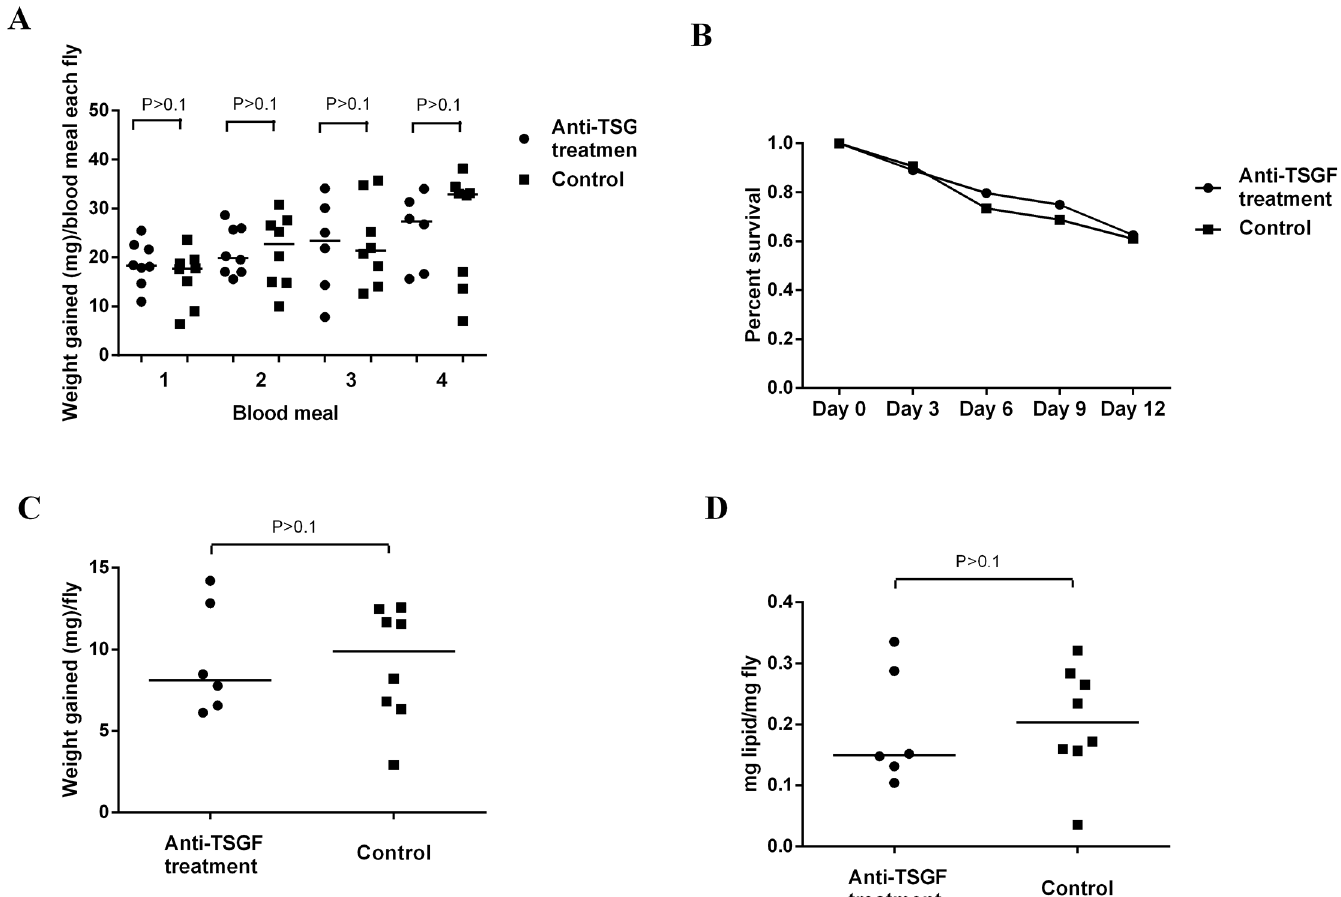
Fig 7. The feeding efficiency and survival of flies that had four bloodmeals on mice that received anti-recTSGF 1 – 2 antibodies. (A) Mean engorged blood meal weights of flies measured before and after each blood meal. Eight cages of flies were allowed to feed on mice at Day 2, Day 5, Day 8 and Day 11 after the mice received rabbit anti-recTSGF treatment. Cages were weighed before and after each blood meal. Each data point corresponds to one cage, which includes the average blood engorgement data for all alive flies in that cage (n = 8 flies per cage at the beginning). (B) Percent survival of flies maintained on rec-TSGF antibody treated and control mice, respectively. The first day they were exposed to mice is considered Day 0. Both groups had 64 flies at the beginning of the experiment. (C) Average weight change in each cage between Day 1 and Day 12. Each data point represents the average weight change in each cage. As one mouse in the TSGF antibody treated group died before the 3 rd blood meal, 6 cages of flies from the TSGF antibody treated group and 8 cages from the control group were measured here. (D): Lipid levels determined from flies 72 h after their 4th blood meal. Each data point represents the average of all alive flies in each cage (n = 6 cages in TSGF antibody treated group and n = 8 cages in control group). Statistical analyses were performed using the Mann Whitney test in the GraphPad Prism 6 software package. No significant difference were detected between the two groups (P >